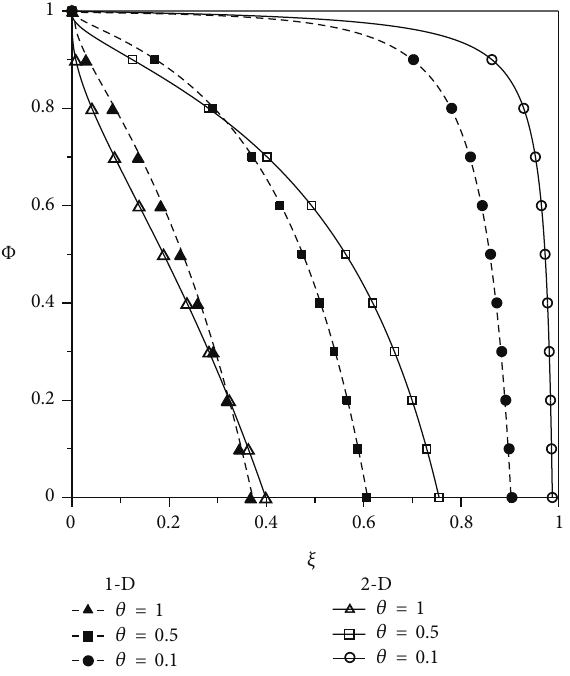
Figure 2: Parameter Φ distribution along the channel.